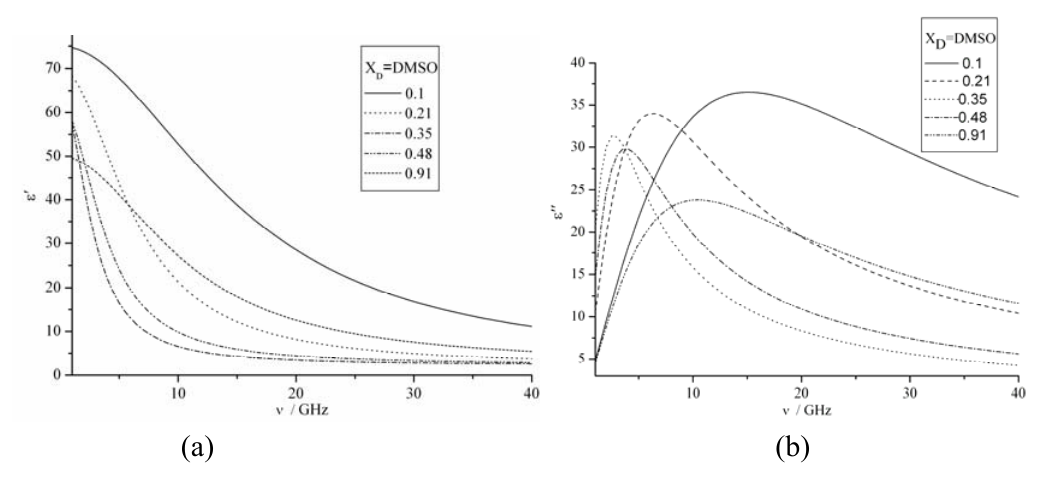
Figure 4. Permittivities and losses for DMSO-water mixtures at various concentrations at